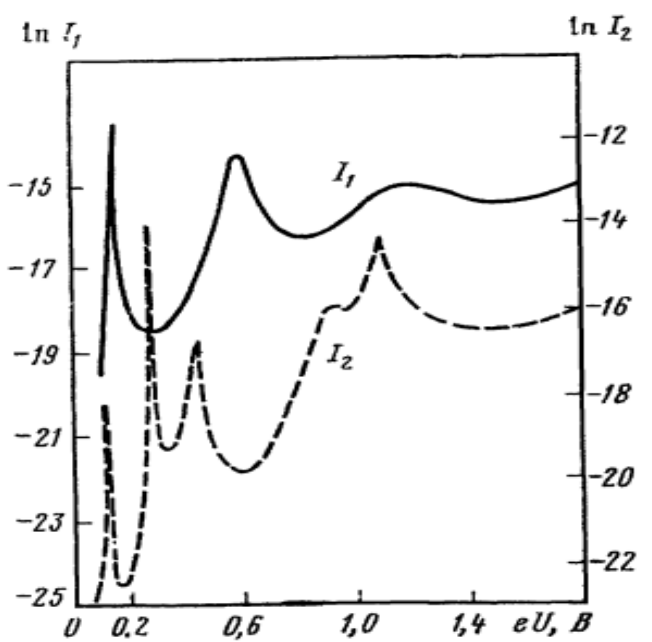
Figure 6. Dependence of the natural logarithm of the current passing along the SL on the voltage for structures with two and three barriers [66].